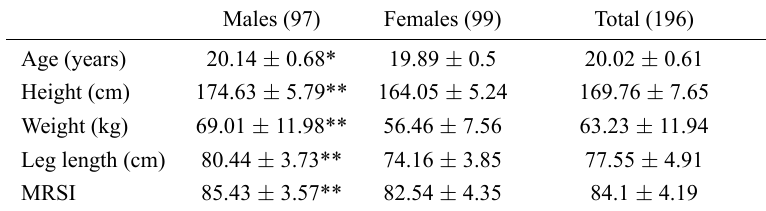
Table 1. Subjects’ characteristics.